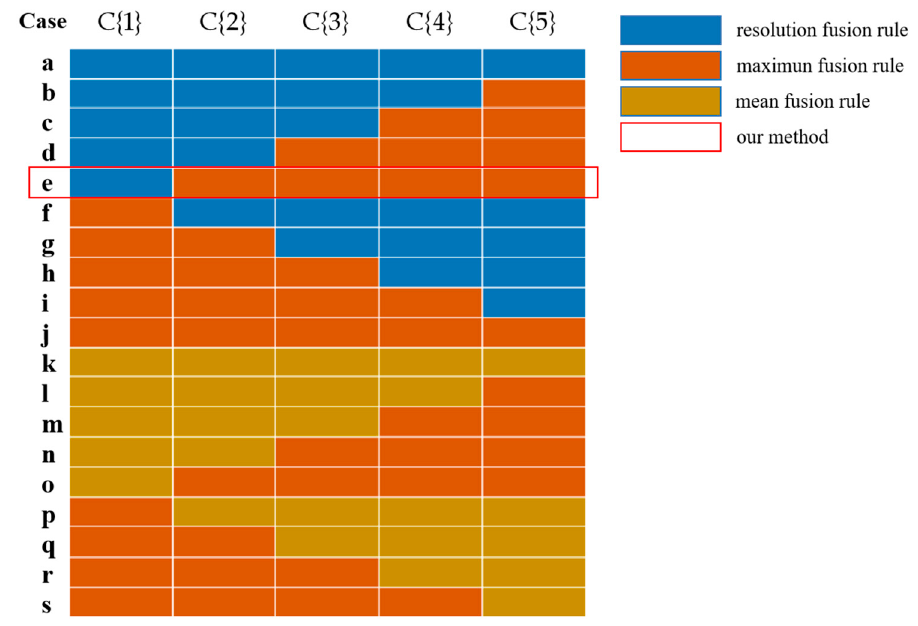
Figure 6. Combination diagram of fusion rules about Curvelet transform coefficients.